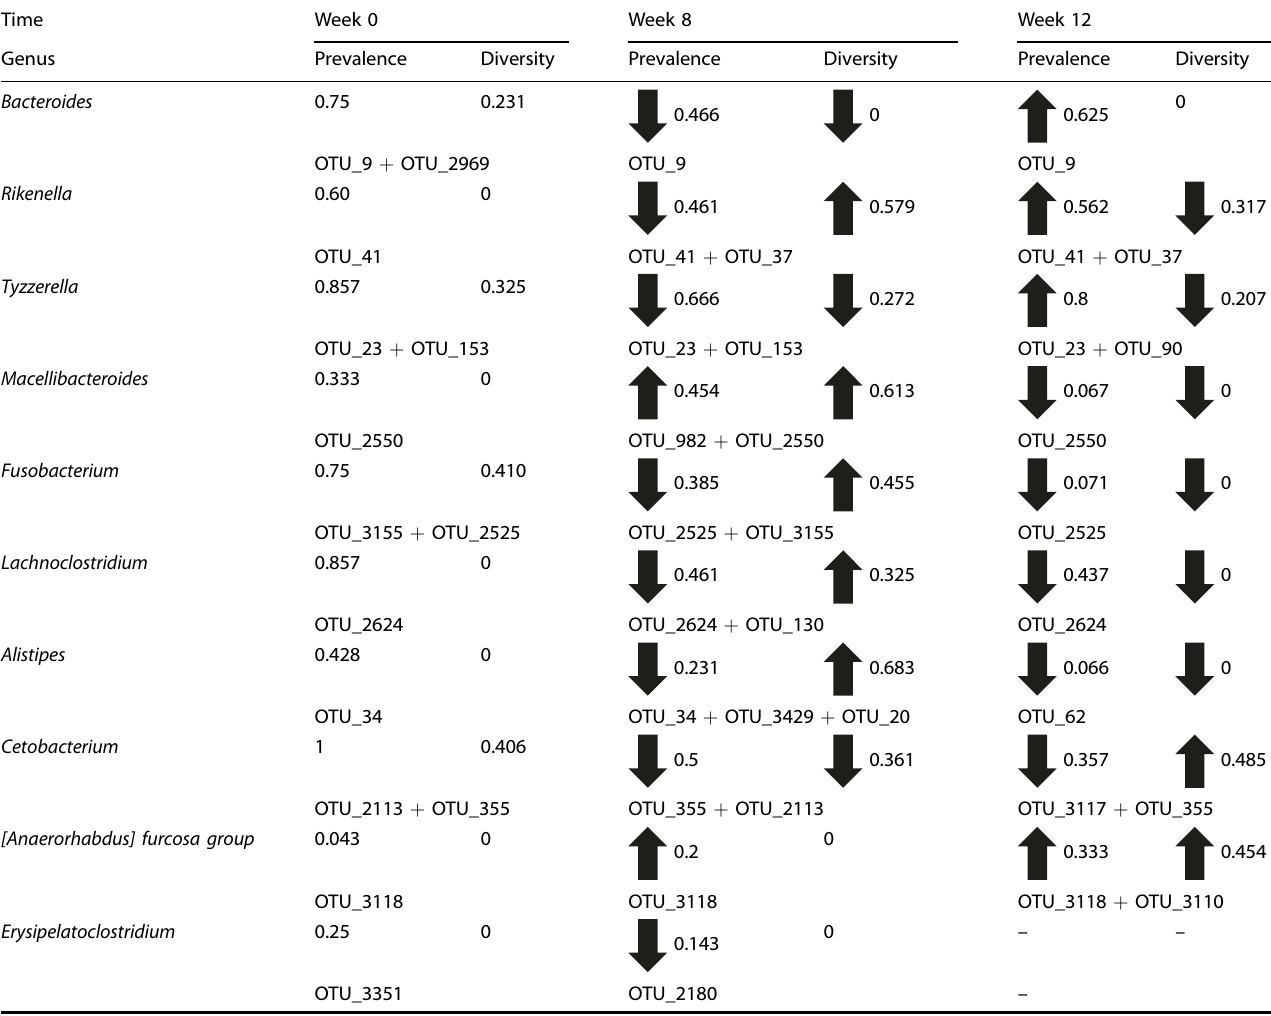
Table 1. Genera with operational taxonomic units (OTUs) showing lottery-like behaviour in the hindgut microbiota of Atlantic